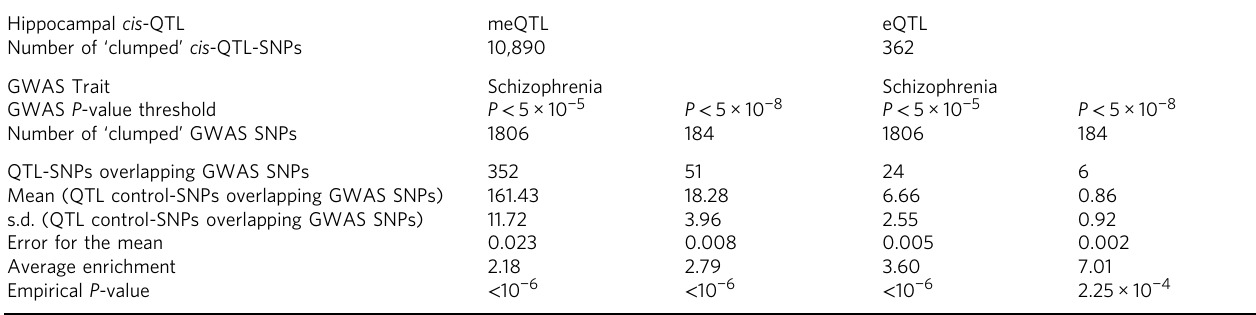
Table 3 Linkage disequilibrium overlap of schizophrenia-associated SNPs with hippocampal cis -meQTL-/eQTL-SNPs Hippocampal cis